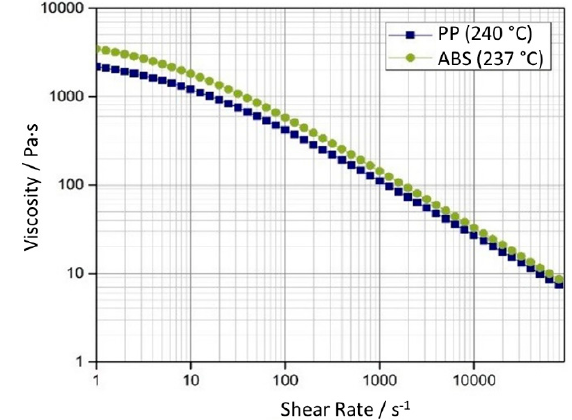
Figure 3. Viscosity of the selected materials at the processing melt temperature.